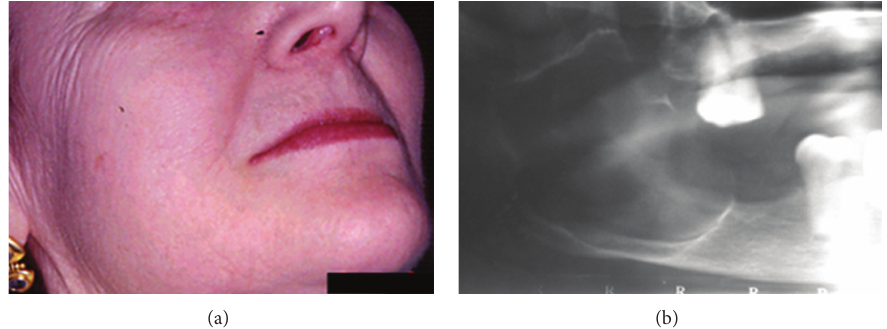
Figure 1: (a) Clinical image. (b) Multilocular radiolucent lesion.